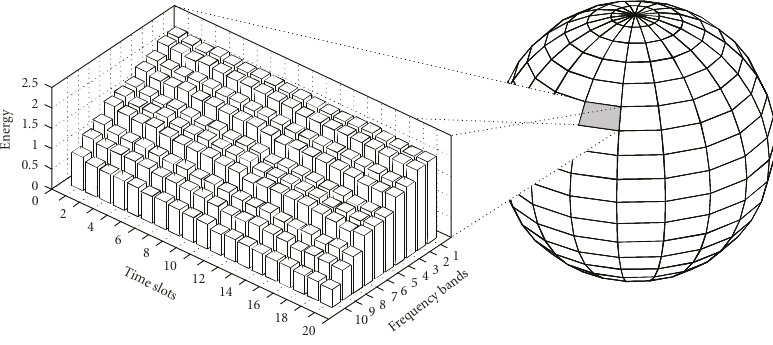
Figure 6: Histogram example of a single directivity